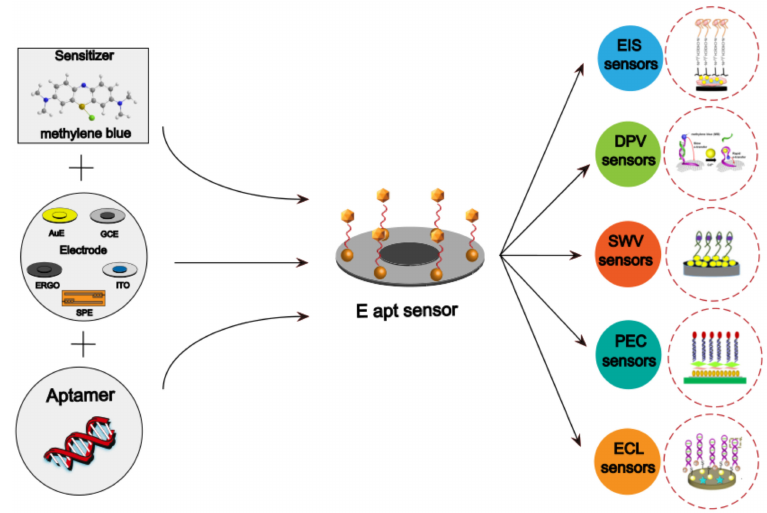
Figure 5. Electrochemical sensor technology is based on aptamers and different